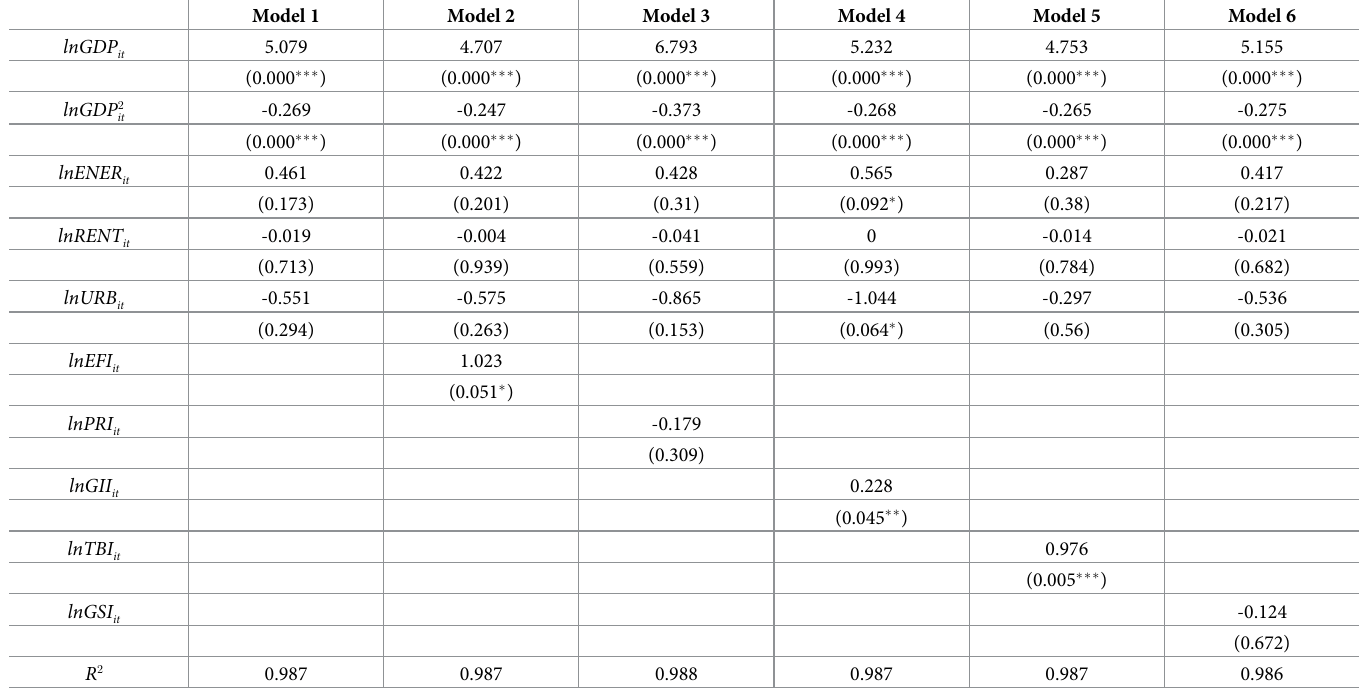
Table 7. Long-run estimation results of PFMOLS Models (when the variables are